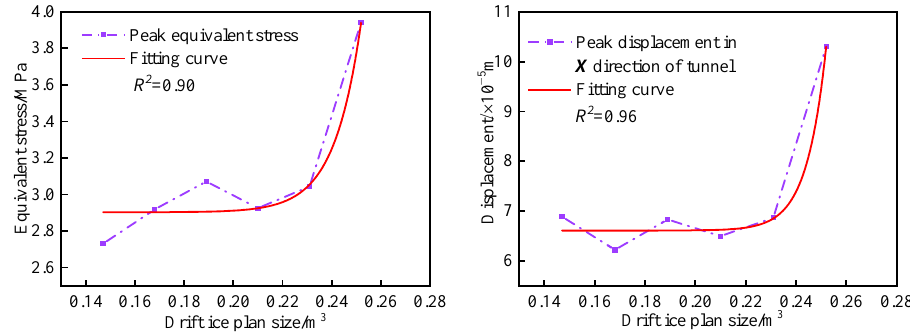
Figure 14. Peak graph of Equivalent stress ( left ) and X -direction displacement ( right ) for different drift ice sizes.